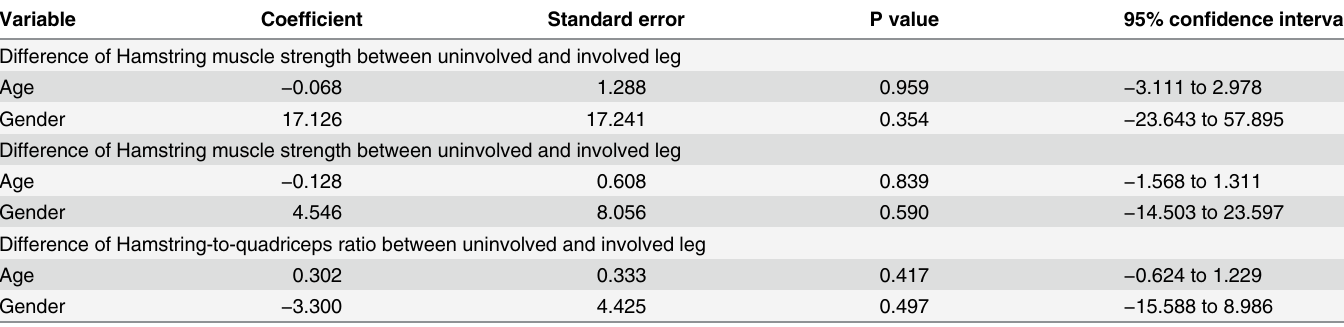
Table 3. Meta-regression analysis between the demographic variables age and gender, and thigh muscle strength parameters.